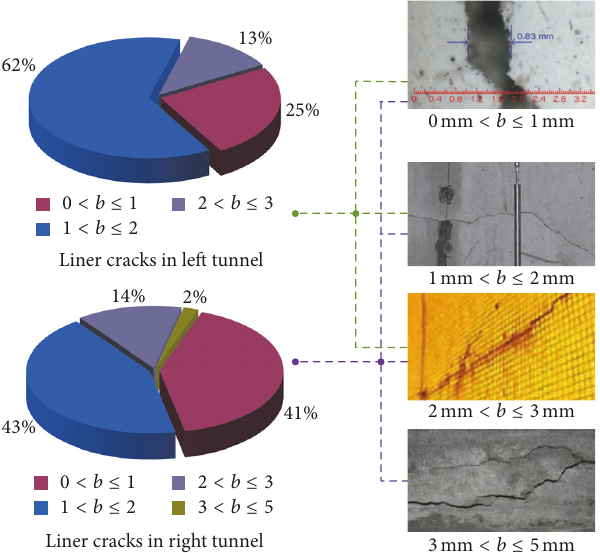
Figure 4: Statistics of liner cracks in Shitigou